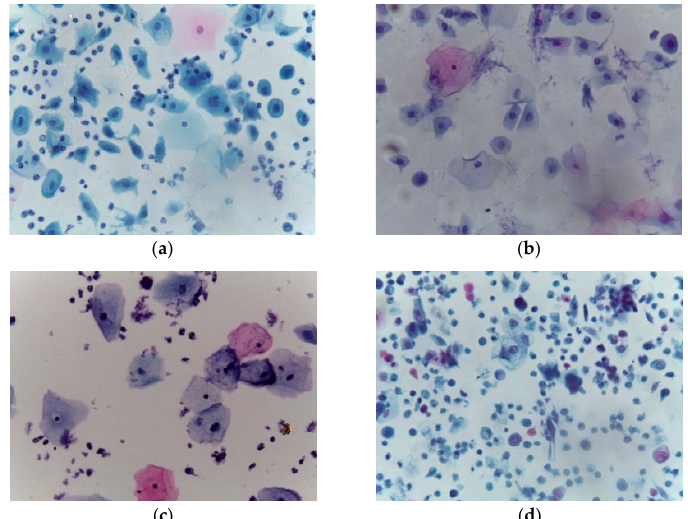
Figure 1. Instances of the slides available in the Mendeley LBC dataset for class; ( a ) high squamous intraepithelial lesion, ( b ) low squamous intraepithelial lesion, ( c ) no intraepithelial malignancy, and ( d ) squamous cell carcinoma.